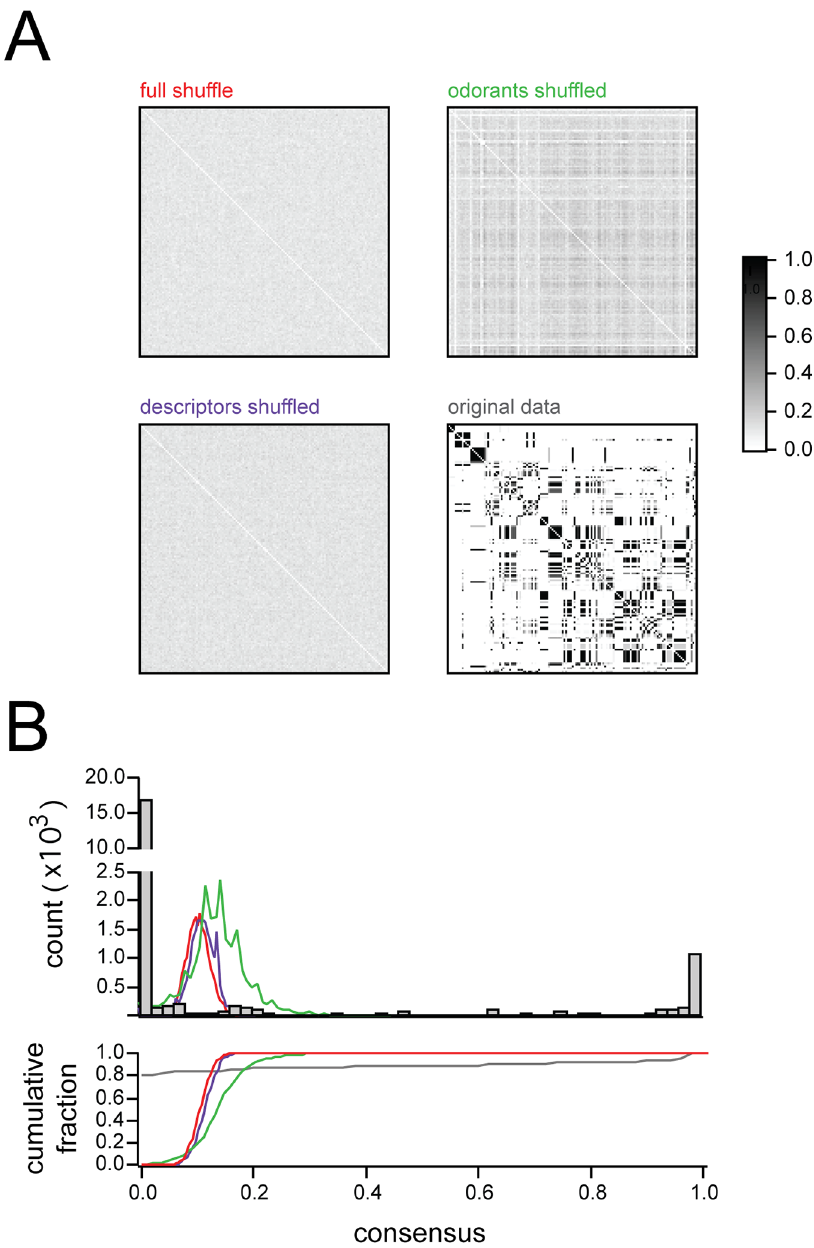
Figure 4. Consensus Matrices for odor-shuffles, descriptor-shuffles, and full-shuffles. A ð Þ Consensus matrices (see text) showing reliability of basis sets when NMF is applied to various shuffled versions of the data. Only the original data shows the bimodal distribution of 1s and 0s characteristic of highly reliable clustering. Image ranges and colorscale same for all 4 matrices. B ð Þ Top: Histograms of consensus matrix values for the three shuffling conditions, and the original data, confirming that only the original data shows a bimodal distribution of 1s and 0s (line colors correspond to labels in A ð Þ ). Bottom: Cumulative histograms, same data as above.